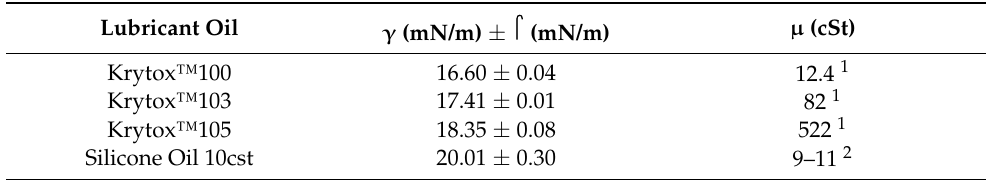
Table 3. Surface tensions ( γ ) and viscosity ( µ ) of the four lubricants used for the fabrication of and Table 2. Average static contact angle with water (WCA) and contact angle hysteresis (CAH) at slippery liquid infused porous surfaces (SLIPS). T amb .